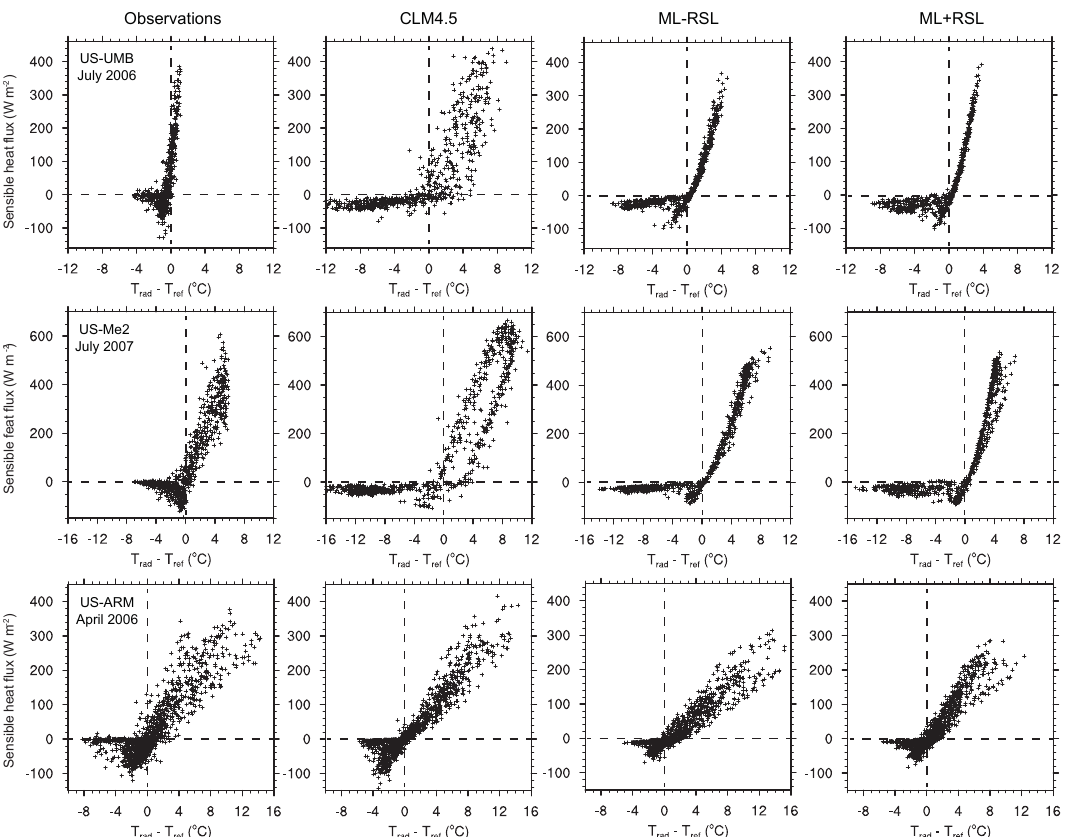
Figure 6. Sensible heat flux in relation to the temperature difference T rad − T ref for US-UMB (July 2006), US-Me2 (July 2007), and US-ARM (April 2006). Shown are the observations (left column) and model results for CLM4.5, ML-RSL, and ML +